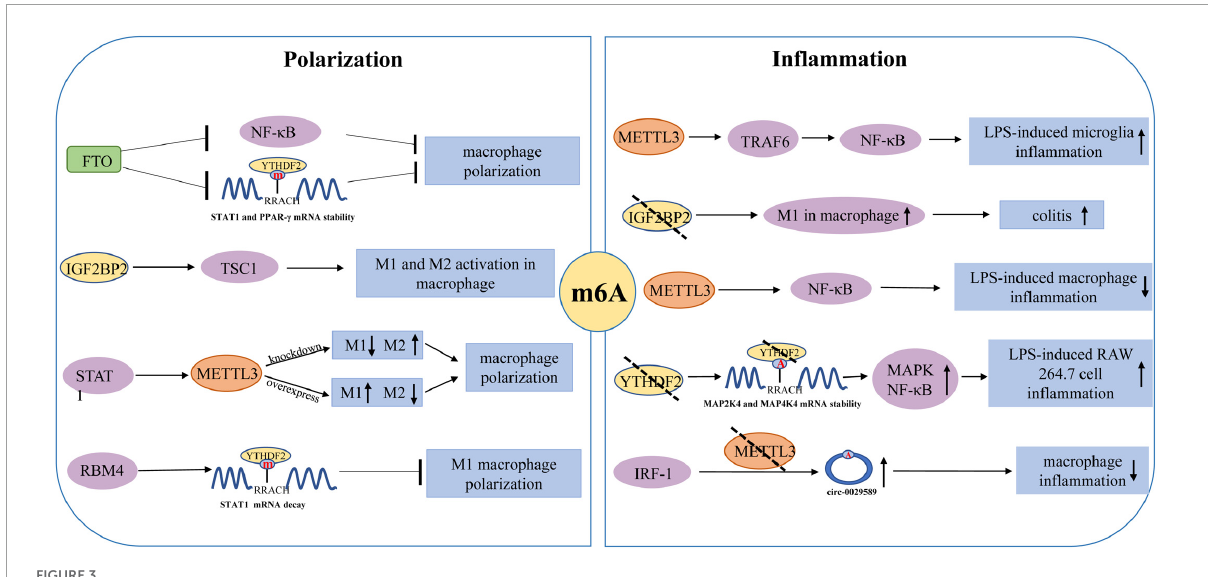
FIGURE3 Regulatory role of m6A modification in the polarization of macrophages and macrophages/microglia mediated inflammation.